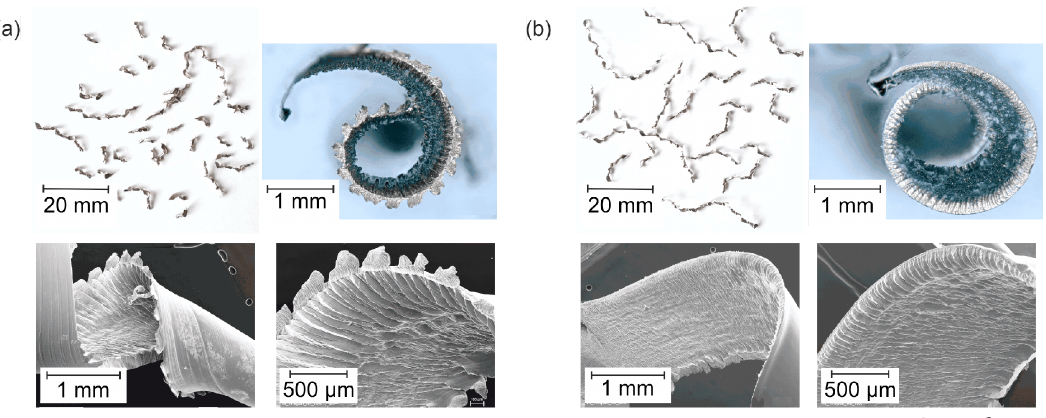
Figure 8. Chips formed during machining ( a ) under a normal atmosphere and ( b ) under an XHV-adequate atmosphere.